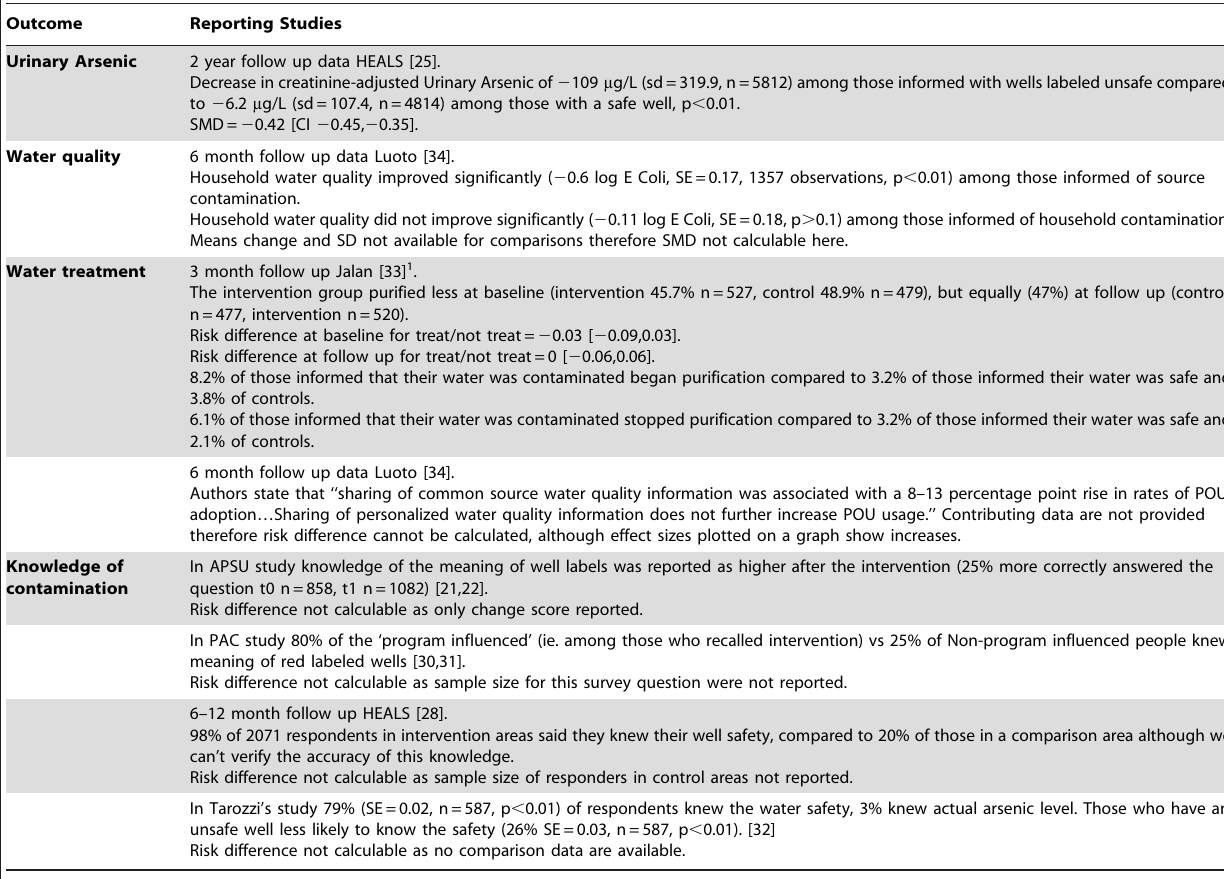
Table 4. Impact on Other Outcomes.